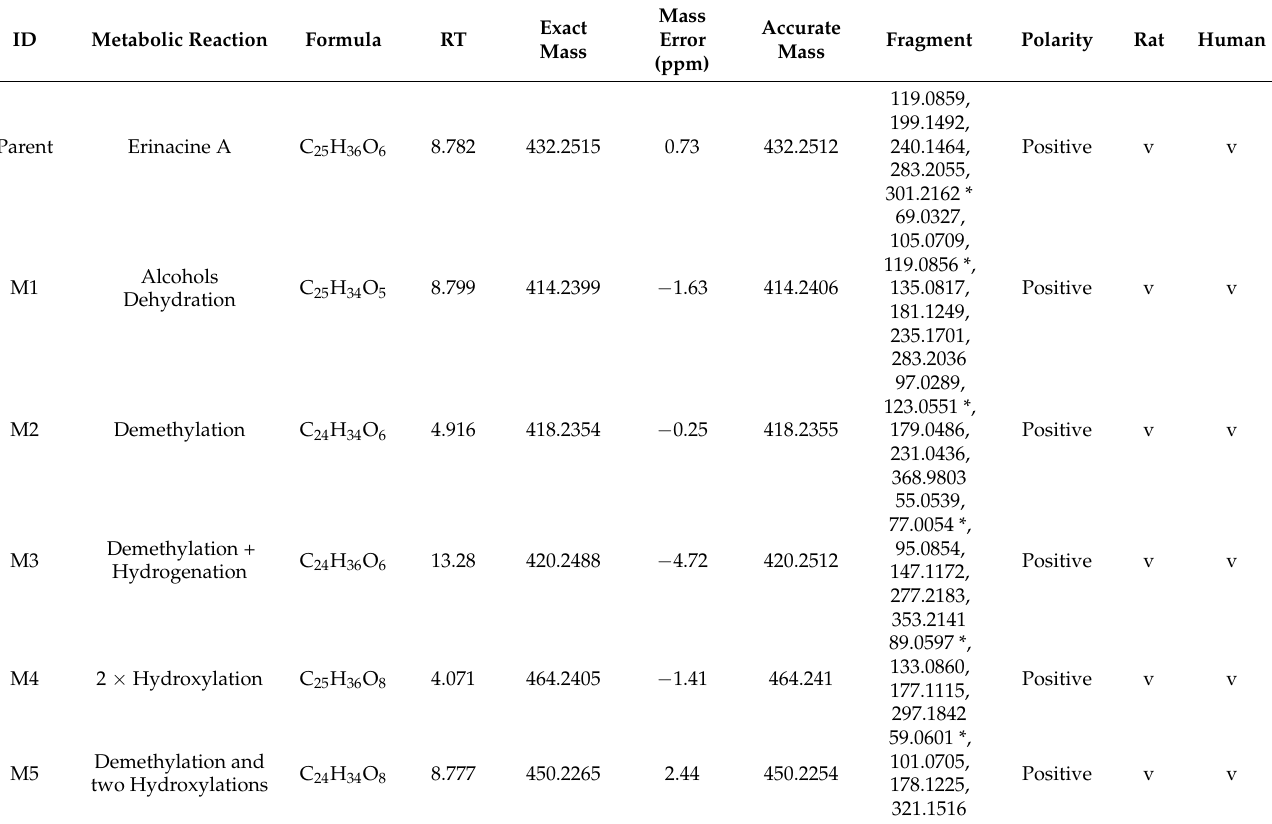
Table 2. Common liver metabolites of erinacine A, detected in rat and human liver S9, with an